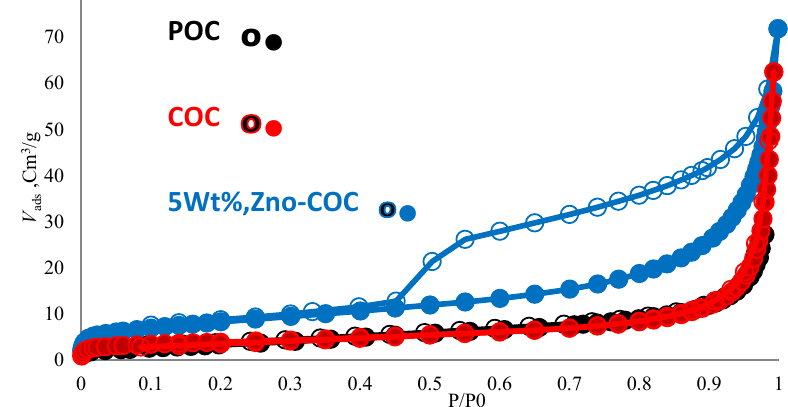
Fig. 3. Nitrogen adsorption/desorption isotherm of clays